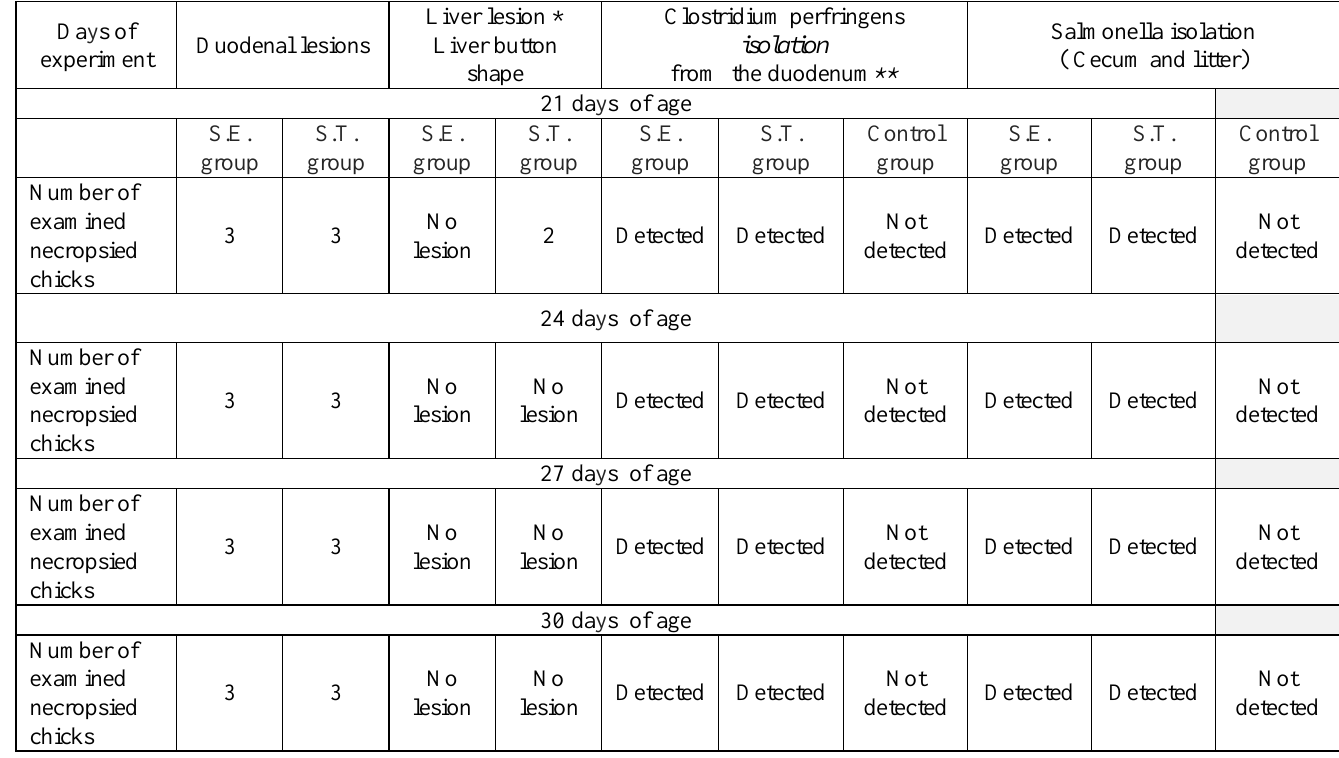
Table 4: Intercurrent of Salmonella and Clostridium perfringens :